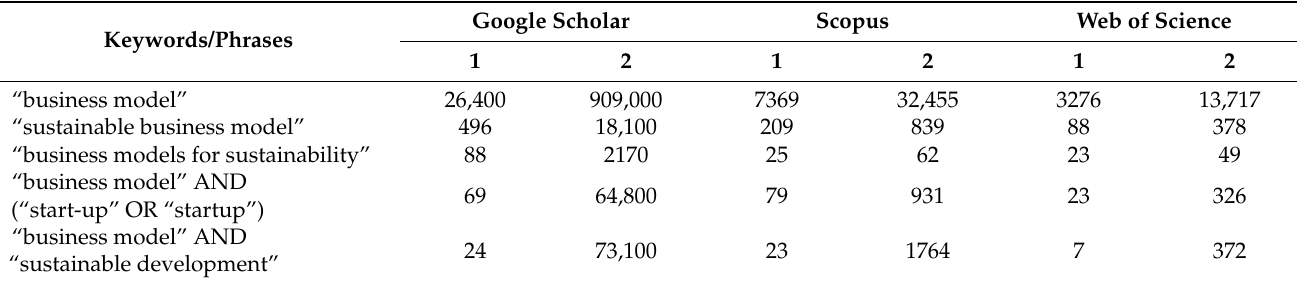
Table 1. Number of document occurrences for keywords and phrases derived from them in the multidisciplinary databases Google Scholar, Scopus and Web of